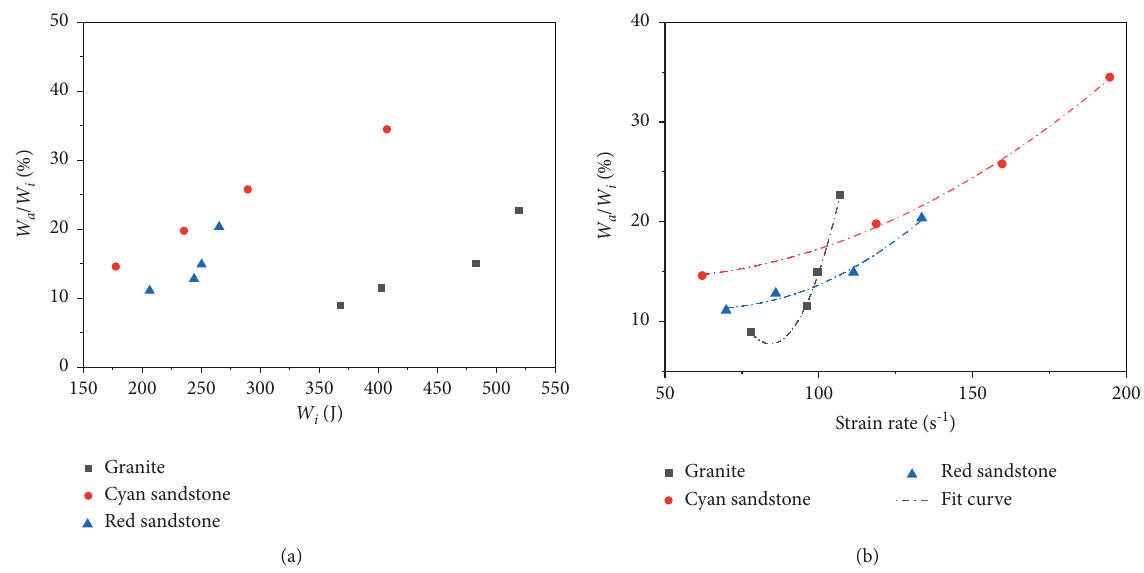
Figure 9: Variations of energy absorption rate versus (a) incident energy and (b) strain